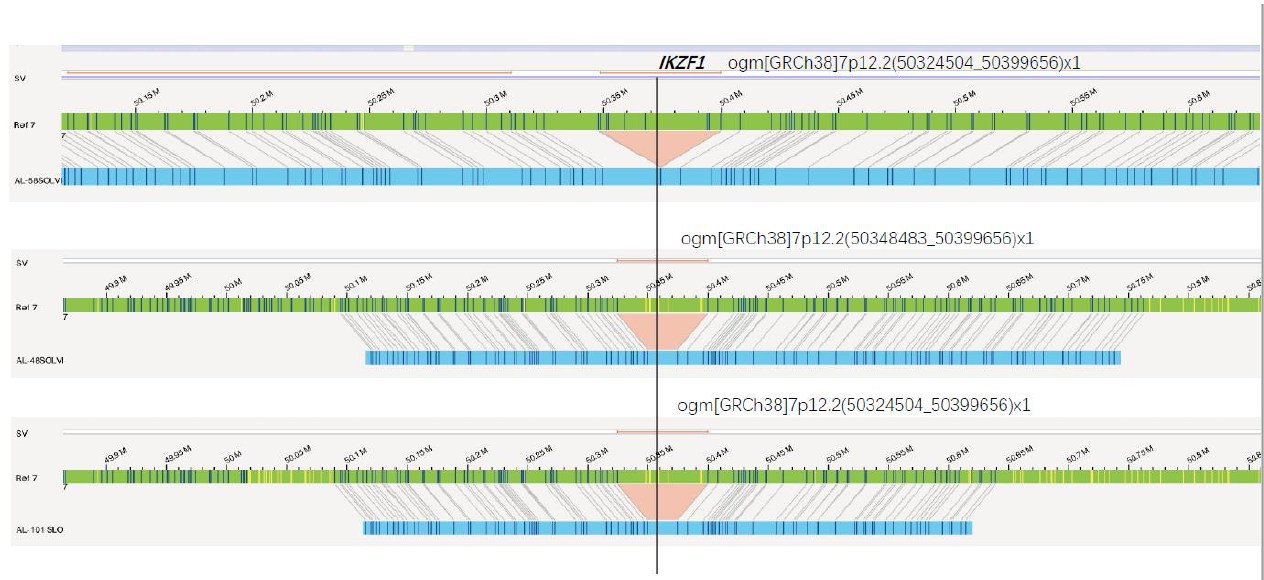
Figure 7. IKZF1 deletion in 7p12.2 detected by OGM. The green bar indicates the reference map, patient maps (sample 48,58,101) were displayed in blue, and deletions were marked in red.